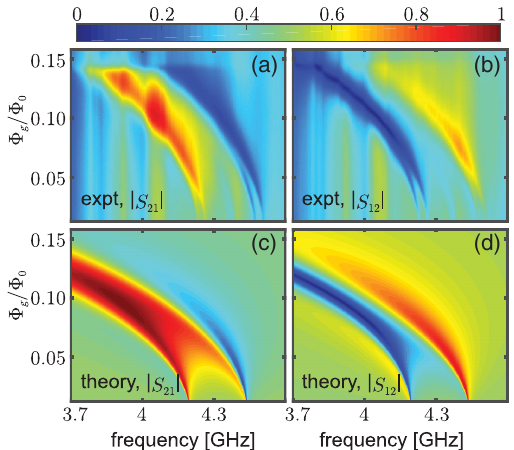
FIG. 12. Measurements (a),(b) and theoretical predictions (c), (d) of j S 21 j and j S 12 j , as a function of probe frequency and amplitude of the oscillatory gradiometric flux, when the device is configured as a counterclockwise circulator. Theoretical predic- tions are made with the expressions in Ref. [19] and the mapping in Appendix A. Circuit parameters are fixed at their design targets ( l 0 ¼ 1 nH, c ¼ 1 pF) and the flux controls are set to match the measurements in (a) and (b): Ω ¼ 2 π × 120 MHz, Φ